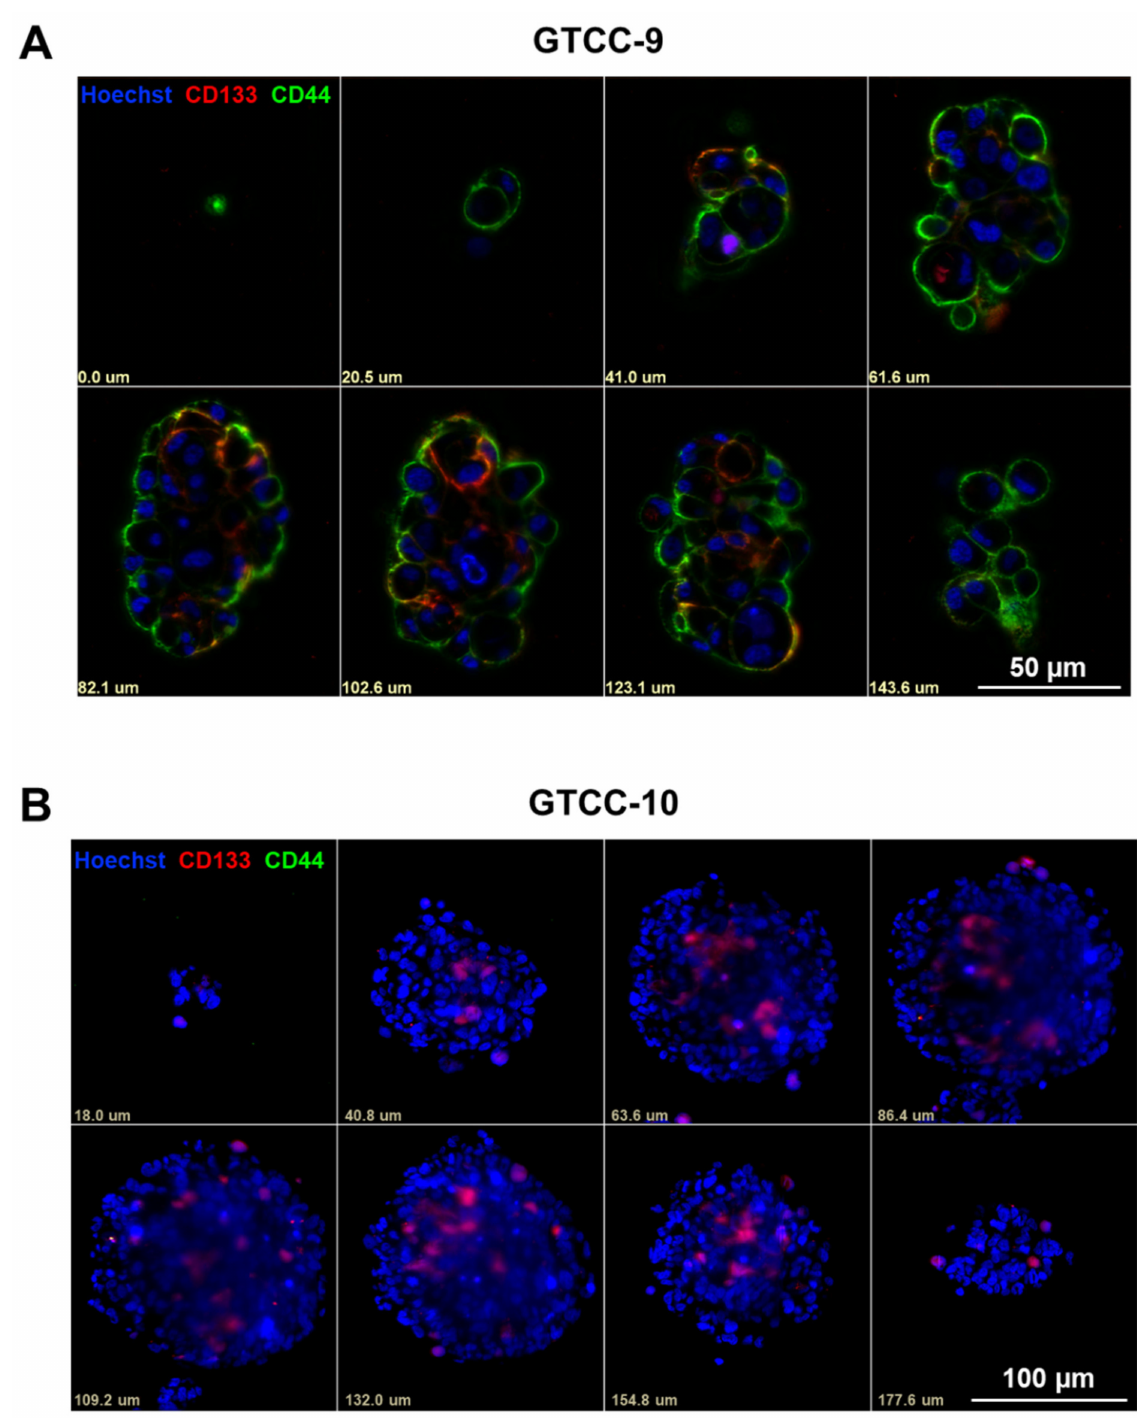
Figure 2. Localisation of CD133 and CD44 stem cell markers within recurrent gliomaspheres. ( A , B ) Light-sheet fluorescence microscopy was used to assess the localisation of CD133 and CD44 stem cell biomarkers in GTCC-9 ( A ) and GTCC-10 ( B ) gliomaspheres; representative images are shown here; scale bar = 50 µ m ( A ); scale bar = 100 µ m ( B ); steps between optical slices indicated in µ m in ( A , B ); n = 3 independent experiments